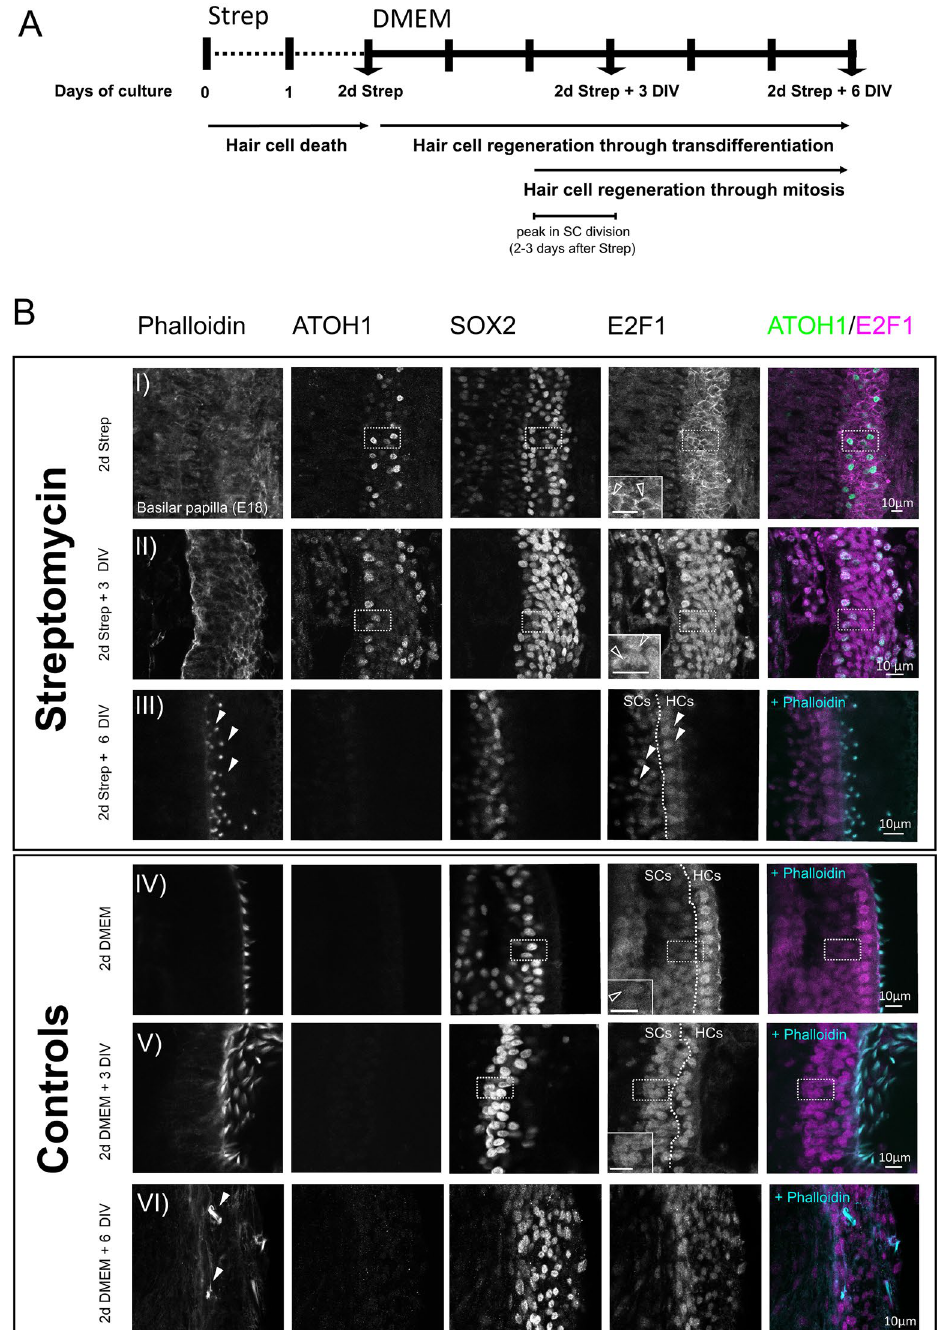
Figure 5. E2F1 expression during HC regeneration in the chick BP. ( A ) Schematic representation of the experimental timeline of organotypic cultures of E18 chick BPs cultured in DMEM and 1% FBS for 2 days with 78 µM streptomycin (Strep) followed an additional 3 or 6 days in vitro (DIV) in the same media without streptomycin. The arrows indicate when the tissue was harvested. ( B ) Immunofluorescence of BPs showing the expression of E2F1 and ATOH1 in HCs (labelled with Phalloidin) and SCs (labelled with SOX2). Cultures maintained for 2 days in media with Strep show ATOH1 re-activation in some SCs whereas a downregulation of nuclear E2F1 expression is observed in comparison to control cultures maintained in DMEM (hollow arrowheads in zoom in areas in row (I) and (IV); scale bar: 10 µm. In BPs cultured for 3 additional days in streptomycin-free media (2d Strep + 3 DIV), nuclear E2F1 expression is observed in SCs (hollow arrowheads in zoom in areas in row II); scale bar: 10 µm). New HCs labelled with Phalloidin are formed in cultures maintained for 6 days in streptomycin- free media after drug treatment (2d Strep + 6 days DIV). In these cultures, ATOH1 is downregulated in SCs labelled with SOX2 whereas E2F1 is expressed in SCs and HCs (arrowheads in row III in E2F1 panel). Control experiments were conducted in parallel in DMEM and at the same timings plus additional days of in vitro (DIV). Technical replicates were three for each experiment with at least three biological